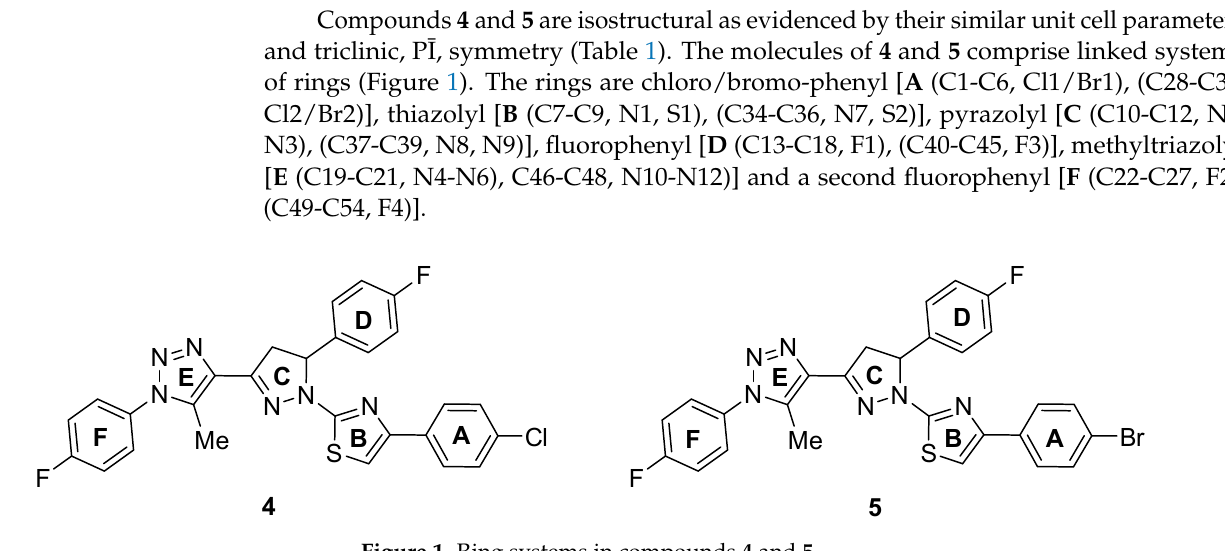
Figure 1. Ring systems in compounds 4 and 5 . Table 1. Crystal and structure refinement data for 4 and 5 .